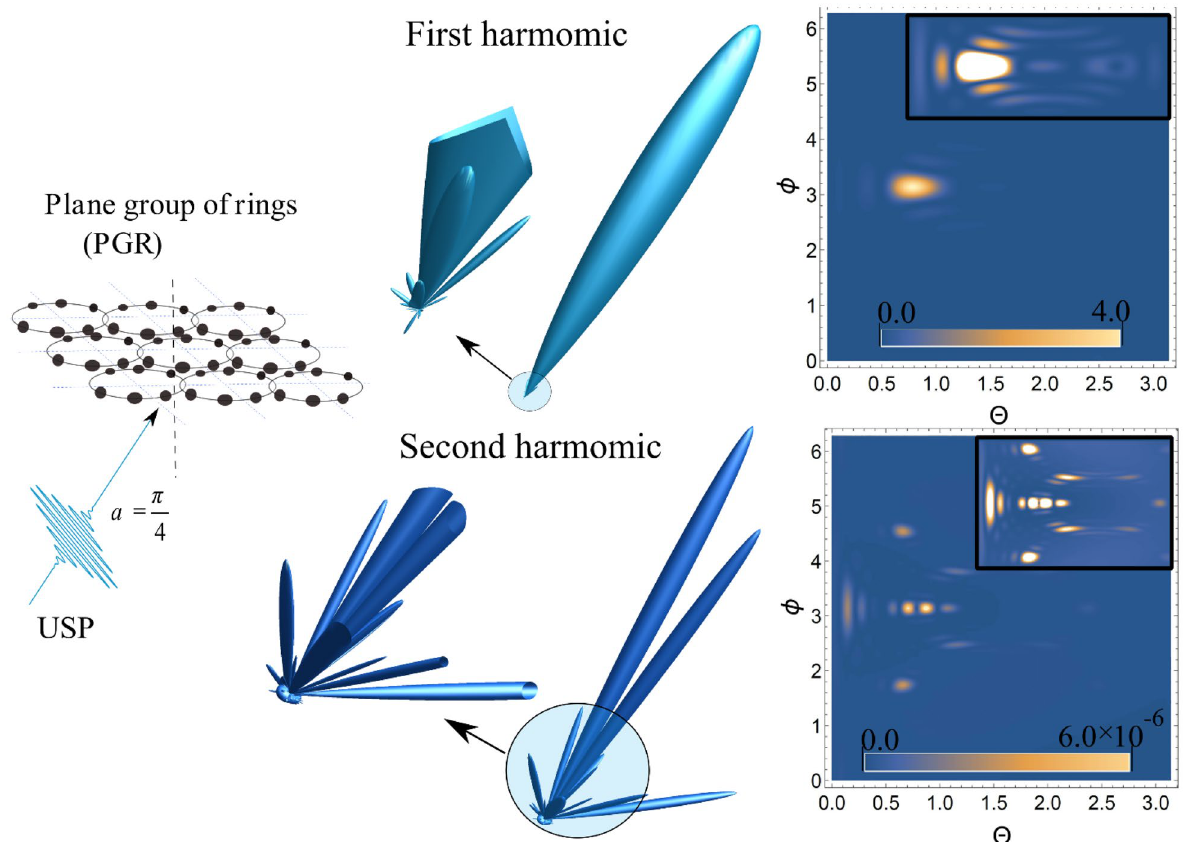
Figure 1. 3D radiation pattern of the scattering spectra USP [see Eq. (1)] and the contour plot for the spectra, where θ and φ are angles (in radians) with a spherical coordinate system, i.e. polar and azimuth angles, respectively. Inserts in contour plots show an enlarged (more contrasting) scatter spectrum. The first harmonic is in the figures above, and the second harmonic is below. A USP was selected with a frequency ω 0 =100 au, a pulse duration γ corresponding to 43 as and amplitude E 0 =1000 au. For the plane group of rings, the number of atoms in the ring is N = 6, the radius of the ring is R = 4 au, the number of grid nodes is 5 × 5 au, (25 rings), and the distance between the centers of adjacent rings is d = 7 au. The angle of incidence α between n 0 and the z axis was selected as α = π/ 4